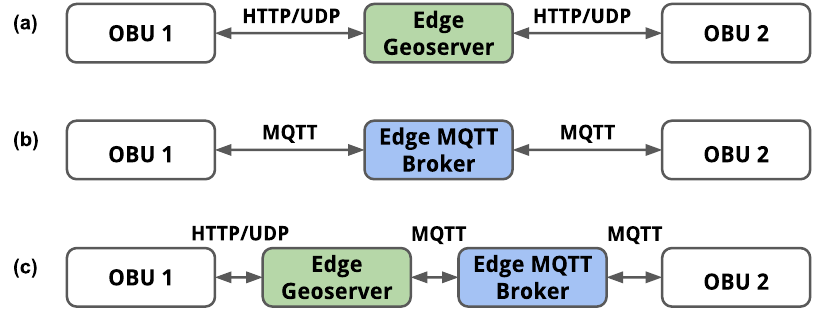
Figure 7. The representation of the test cases with two experimental OBUs. Each test case consists of a different combination of V2X communication protocols between both OBUs and the edge cloud. ( a ) UDP/HTTP-based communications; ( b ) MQTT-based communications; ( c ) Hybrid UDP/HTTP and MQTT-based